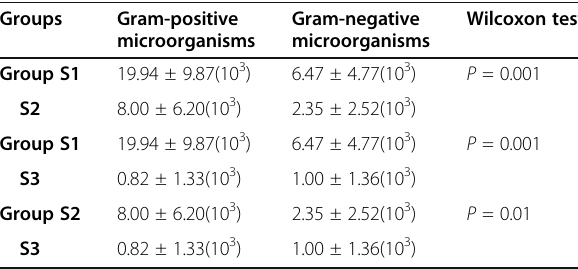
Table 7 Pairwise comparison of the mean colony-forming units of Gram-positive and Gram-negative microorganisms between the groups